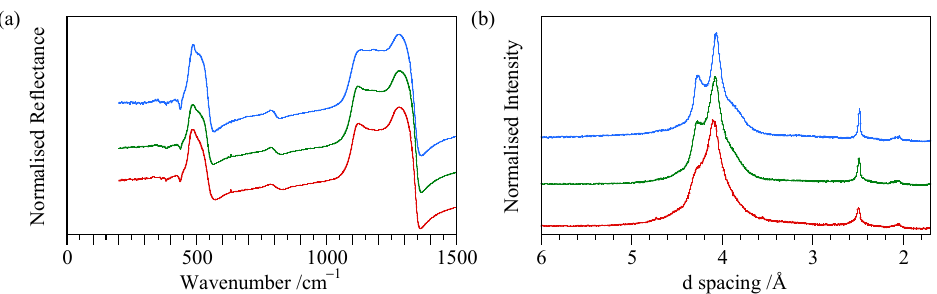
Figure 19. Comparison of polished thin opal-CT samples: red) G33912 from Acari, Caravelli Province, Arequipa Department Peru, green) T2222 from Mount Barker, South Australia, Australia, and blue) G9942 from Angaston, South Australia, Australia. ( a ) 75° angle of incidence specular reflectance spectra and ( b ) XRD patterns. Spectra and XRD patterns have been normalised to the tallest peak and then offset for convenience.